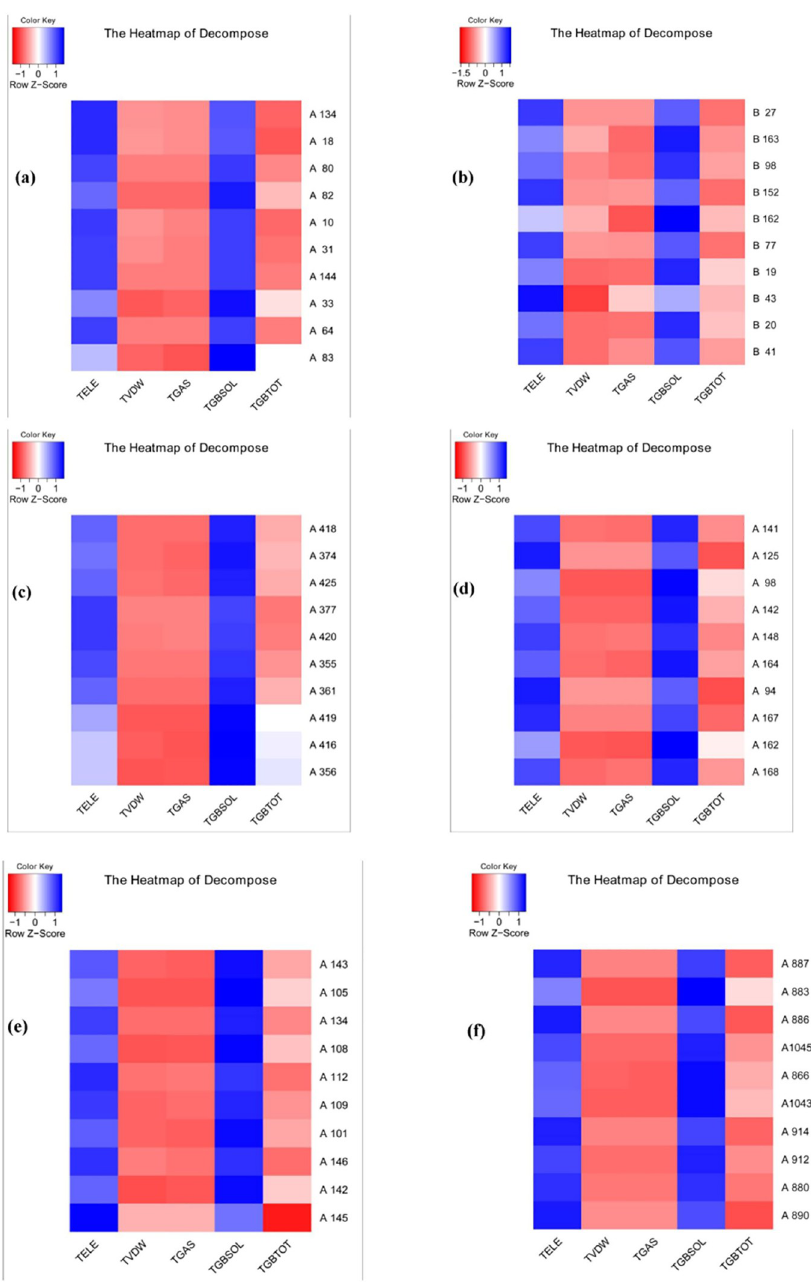
Fig 7. Heatmap showing energy decomposition for top 10 residues ( a ) CDK-2_cmpd44 ( b ) CDK-6_cmpd59 ( c ) Topoisomerase-I_cmpd37 ( d ) Topoisomerase-II_cmpd37 ( e ) Bcl-2_cmpd46 ( f ) VEGFR-2_cmpd37.